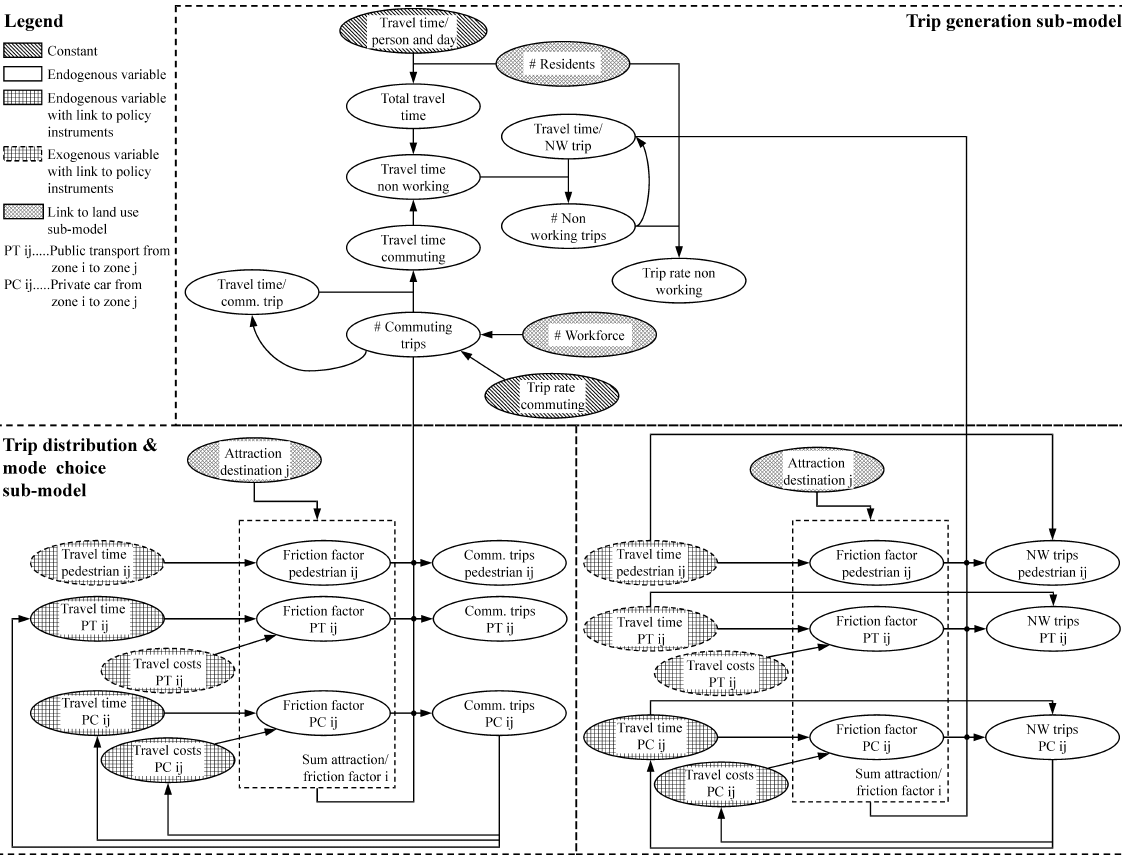
Figure 3: Sub-system diagram transport model